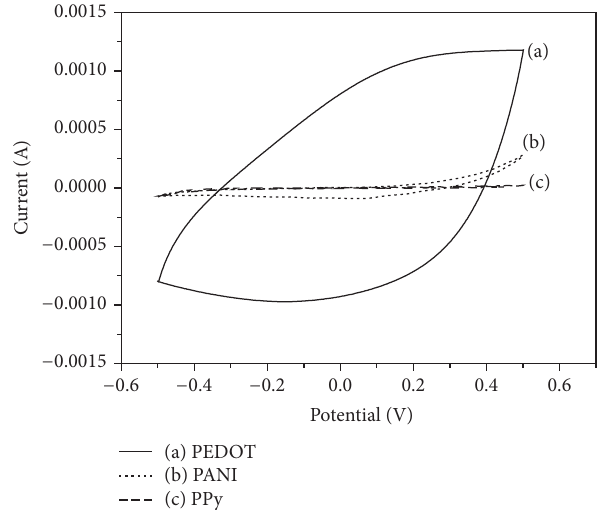
Figure 6: CVs of (a) PEDOT, (b) PANI, and (c) PPy films elec- tropolymerized at from 10mM monomer concentration recorded in 0.1M KCl solution at the scan rate of